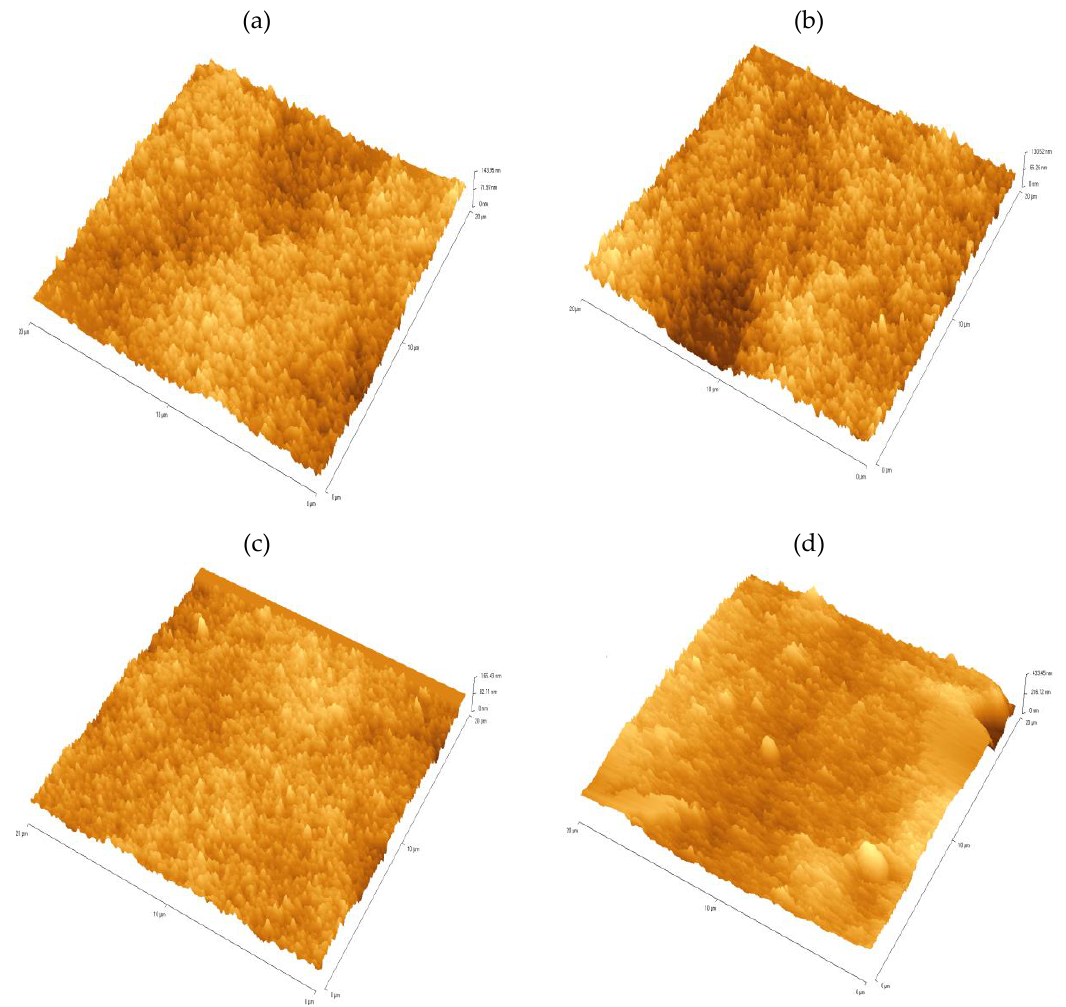
Figure 7. The AFM micrographs of TiO 2 with anchored ( a ) 2a, ( b ) 2b, ( c ) 2c and ( d ) N719.